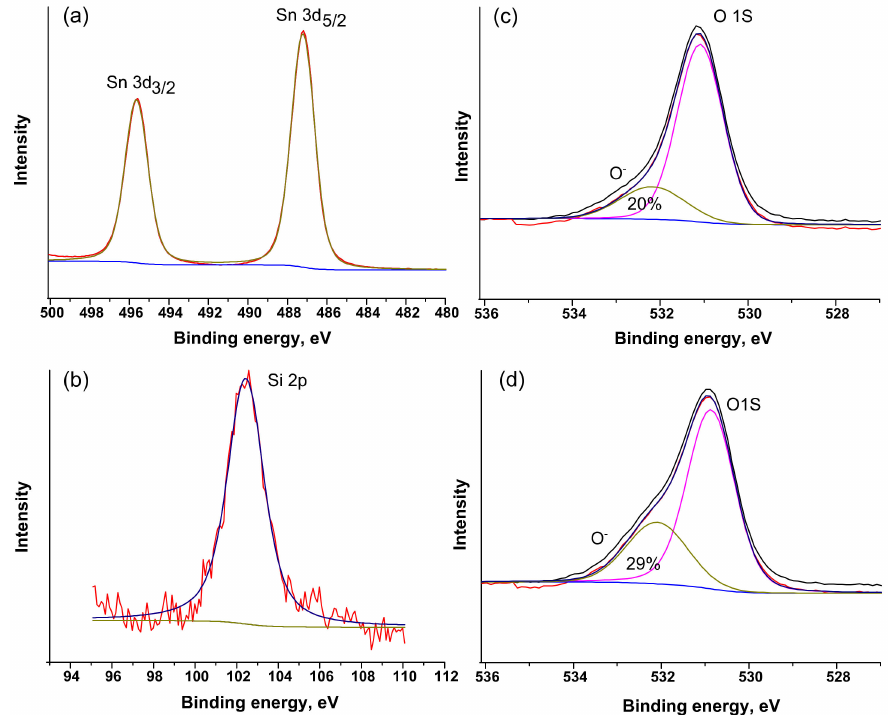
Figure 9. X-ray photoelectron spectra: ( a ) SnSi13 sample, Sn3 d region; ( b ) SnSi13 sample, Si2 p region; ( c ) SnO 2 sample, O1 s region; ( d ) SnSi13 sample, O1 s